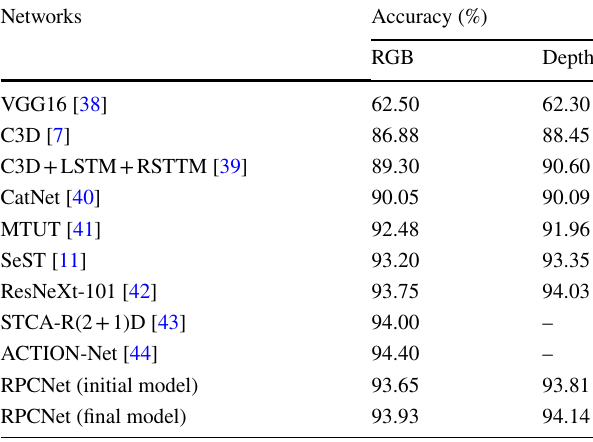
Table 4 Comparison results of our models with other state-of-the-art methods on the test set of EgoGesture [12] dataset Networks